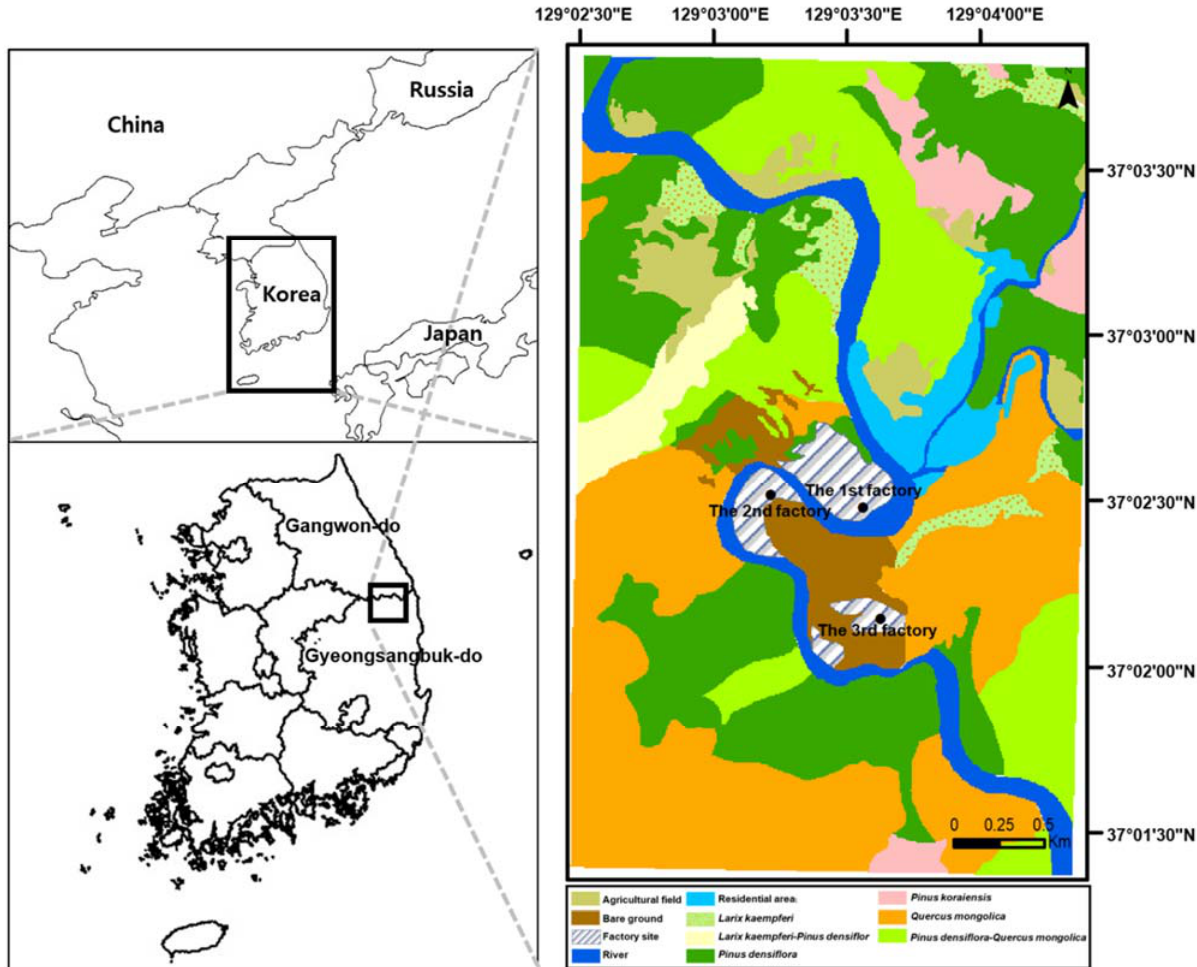
Figure 2. A map showing the study area, the Seokpo zinc smelter, which is located in central eastern Korea. Seokpo zinc smelter is composed of three factories. A colored map shows vegetation and land use types established around the smelter. Dots and the parts expressed with oblique lines around them indicate factories and factory sites.